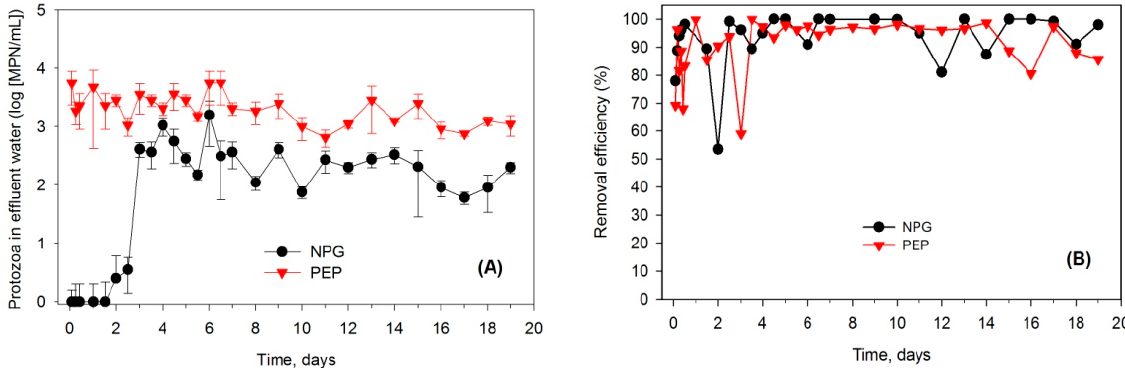
Figure 4. Comparison of the performance between PEP and NPG filters. ( A ) Protozoa in effluent water, ( B ) Removal efficiency.